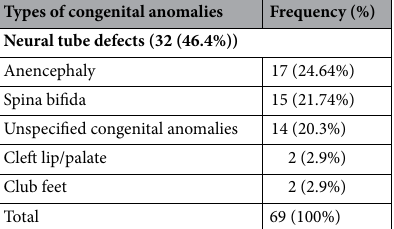
Table 4. The magnitude of congenital anomalies among newborn babies delivered at Felege-Hiwot Comprehensive Specialized Referral hospital, from Sept. 2009 to Aug. 2014, Bahir Dar, Ethiopia.